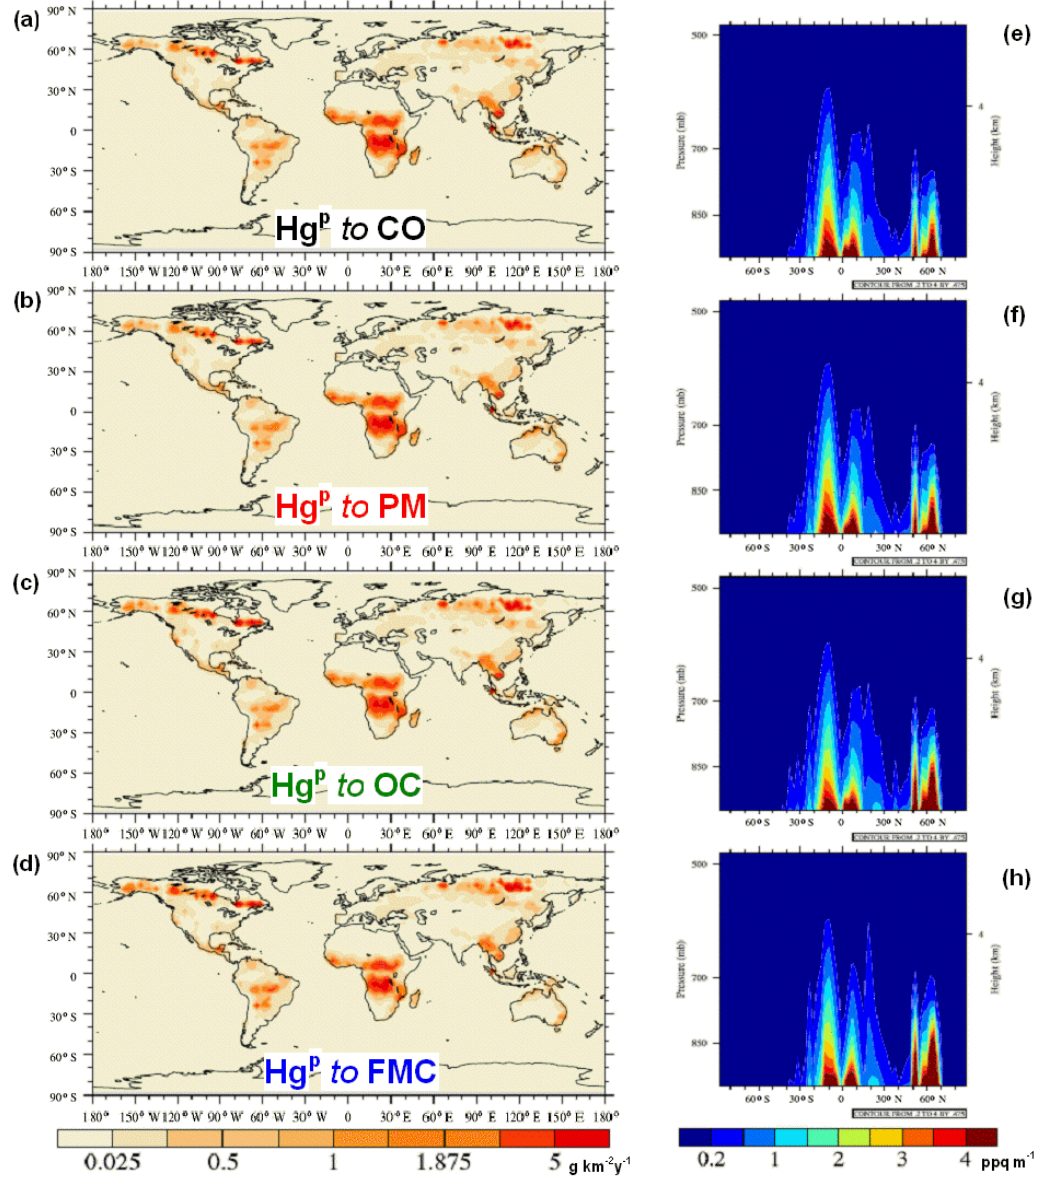
Figure 2. Geographical distribution (a–d) and PBL-type vertical profiles (e–h) of the Hg P emissions as injected in the model, when mapped to CO (a, e) , PM (b, f) and OC (c, g) and when speciation is determined by FMC (d, h) . For the emissions mapped to CO, only the speciation (15:85 Hg P :Hg 0 ) is shown for ( g )